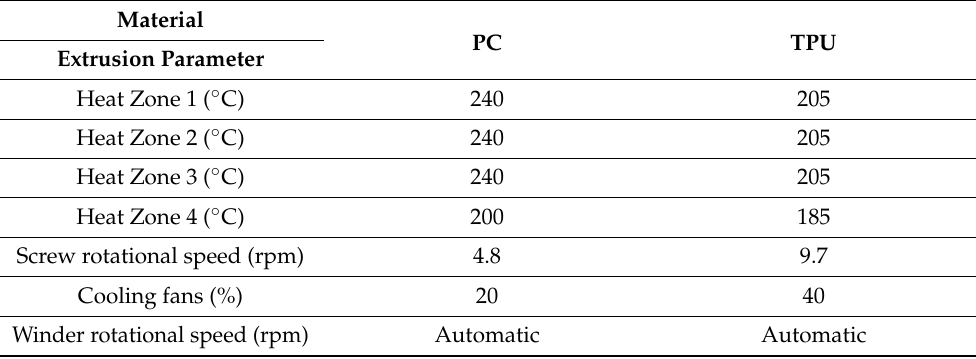
Table 2. Extrusion parameters for PC and TPU materials during filament fabrication in the